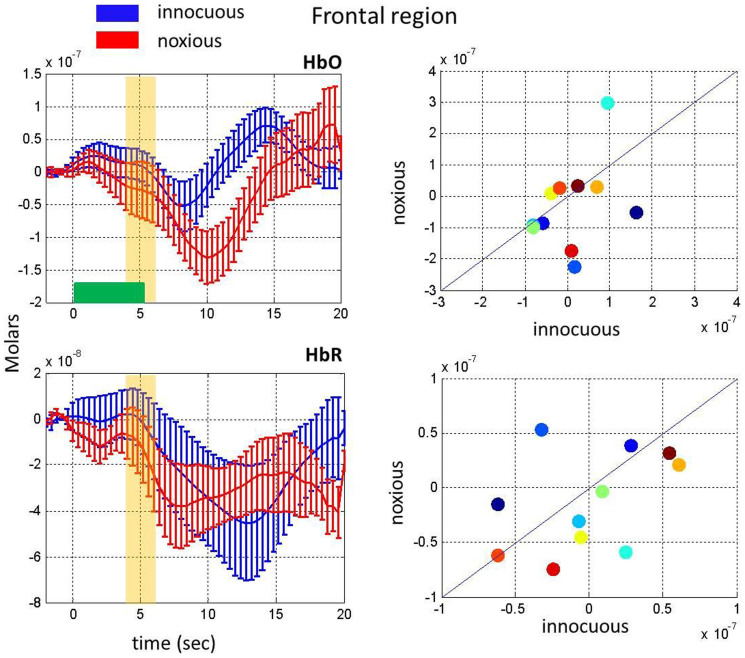
Comparison of the hemodynamic response to innocuous and noxious stimuli in the first three minutes on the frontal region.Changes in HbO (top, left) and HbR (bottom, left) as a response to innocuous stimuli (blue) and noxious stimuli (red). Yellow bars show the interval chosen to obtain the mean responses depicted in the scatter plots. The right panels show a scatter plot comparing the hemodynamic response for each subject averaged over the yellow bar during the first three minutes for HbO (top) and HbR (bottom). The horizontal green bar shows the stimulus duration.